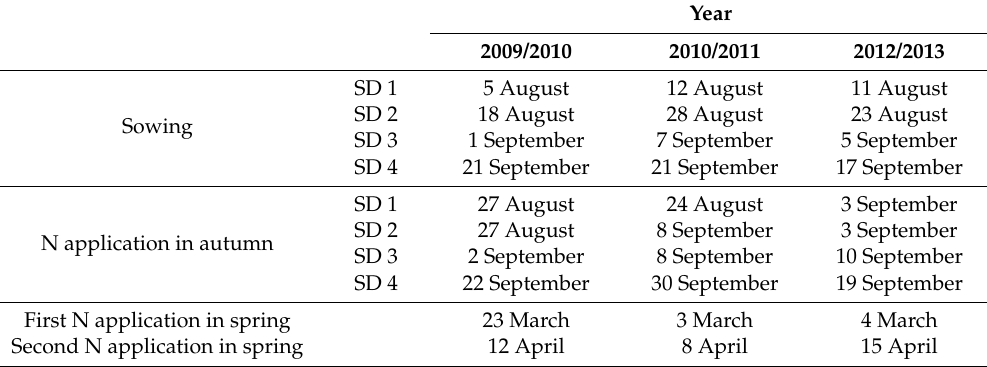
Table 6. Dates of sowing, autumn, and spring N application of winter oilseed